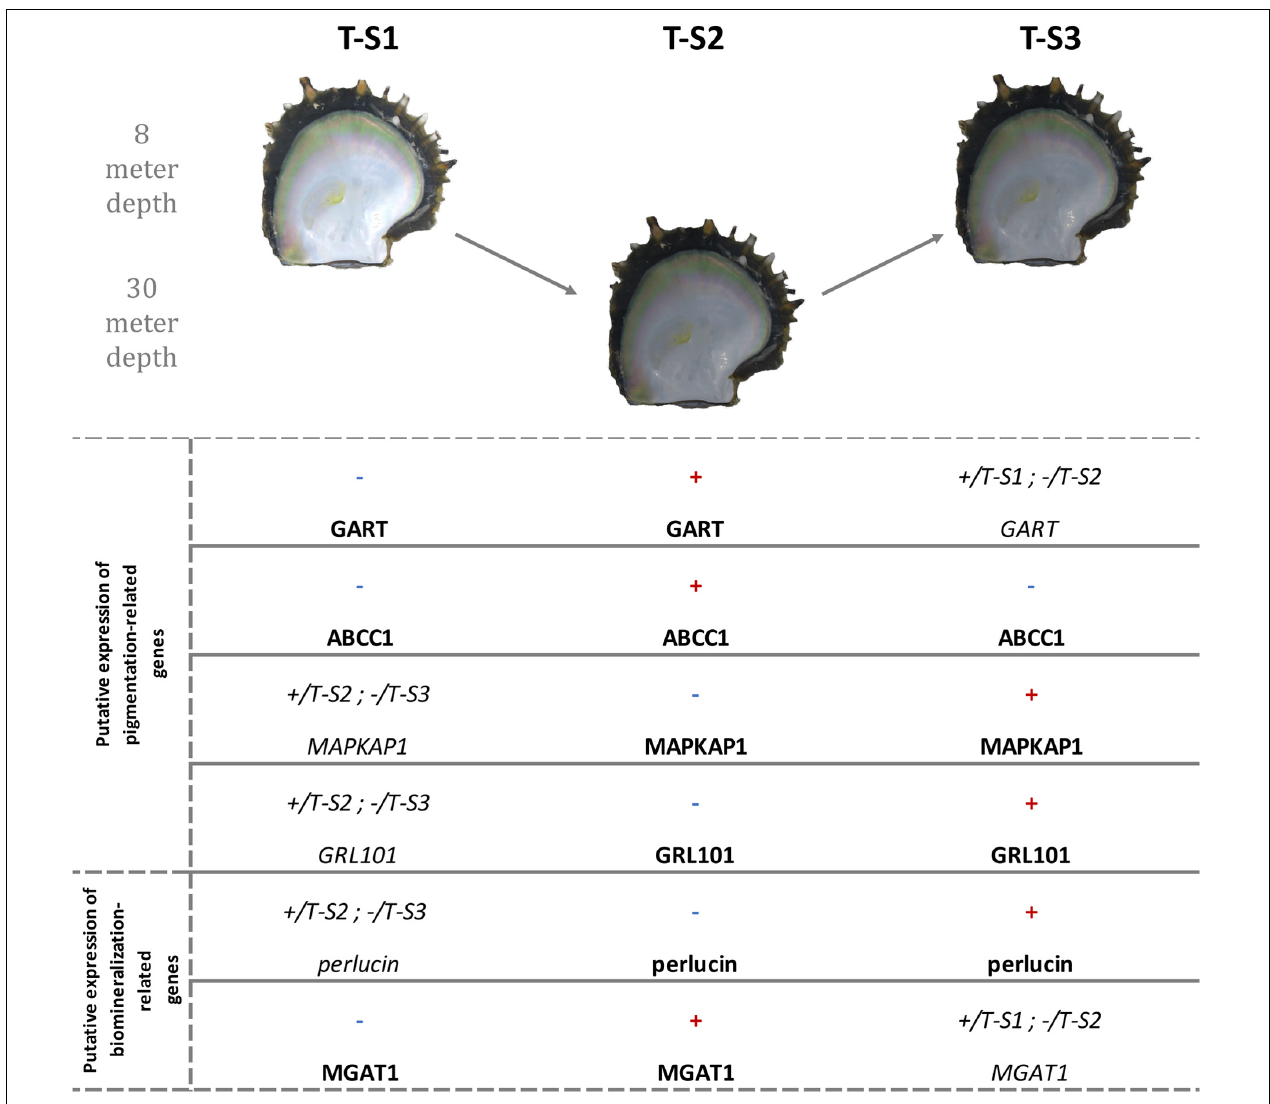
FIGURE 8 | Methylation direction changes in candidate genes linked to inner shell color darkening in the depth treatment individuals at the three successive sampling times (T-S1, T-S2, and T-S3). The first four genes are involved in pigmentation processes, and the last two in biomineralization processes. Red “+” illustrates a significant hypermethylation of at least one CpG and blue “-” illustrates a significant hypomethylation of at least one CpG. +/T-S(a) and -/T-S(b) mean that the methylation in the present sampling time is more methylated than in the T-S(a) and less than in the T-S(b). GART , trifunctional purine biosynthetic protein adenosine-3; ABCC1 , multidrug resistance-associated protein 1; MAPKAP1 , target of rapamycin complex 2 subunit MAPKAP1 ; GRL101 , G-protein coupled receptor GRL101 ; MGAT1 , alpha-1,3-mannosyl-glycoprotein-2-beta-n-acetylglucosaminyltransferase. Pictures showed are